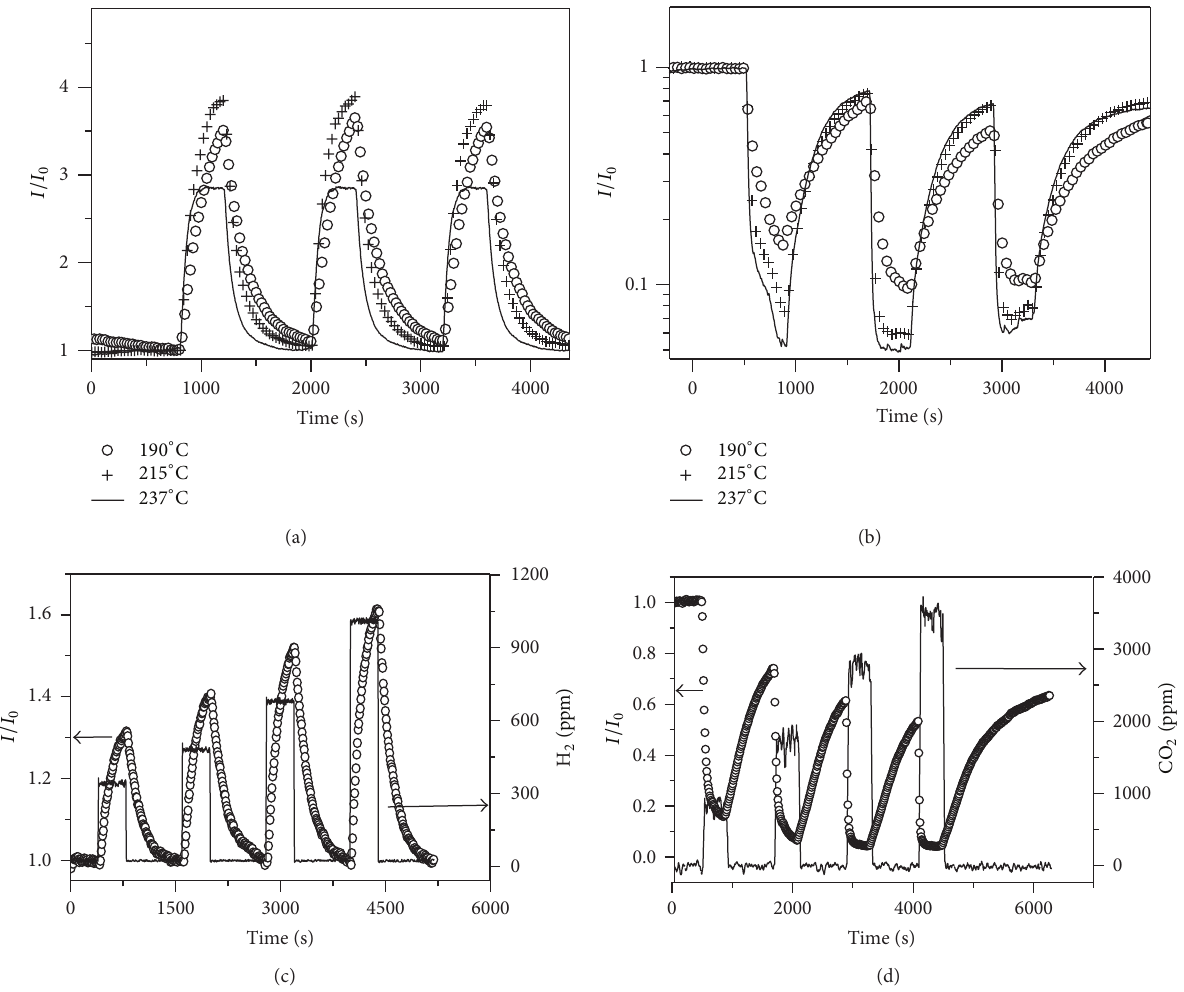
Figure 6: Normalized current sensing response of the TiO 2−𝑥 nanosensor to test gases in dry air. (a) and (b) show, respectively, tests to three consecutive pulses of 1.7% of H 2 and 8% CO 2 , at three different temperatures (190 ∘ C—open circles, 215 ∘ C—crosses, and 237 ∘ C—continuous line). The sensing response (open circles) to ppm concentration (continuous line) of H 2 , and CO 2 test gases at working temperature of 220 ∘ C are also shown in (c) and (d),